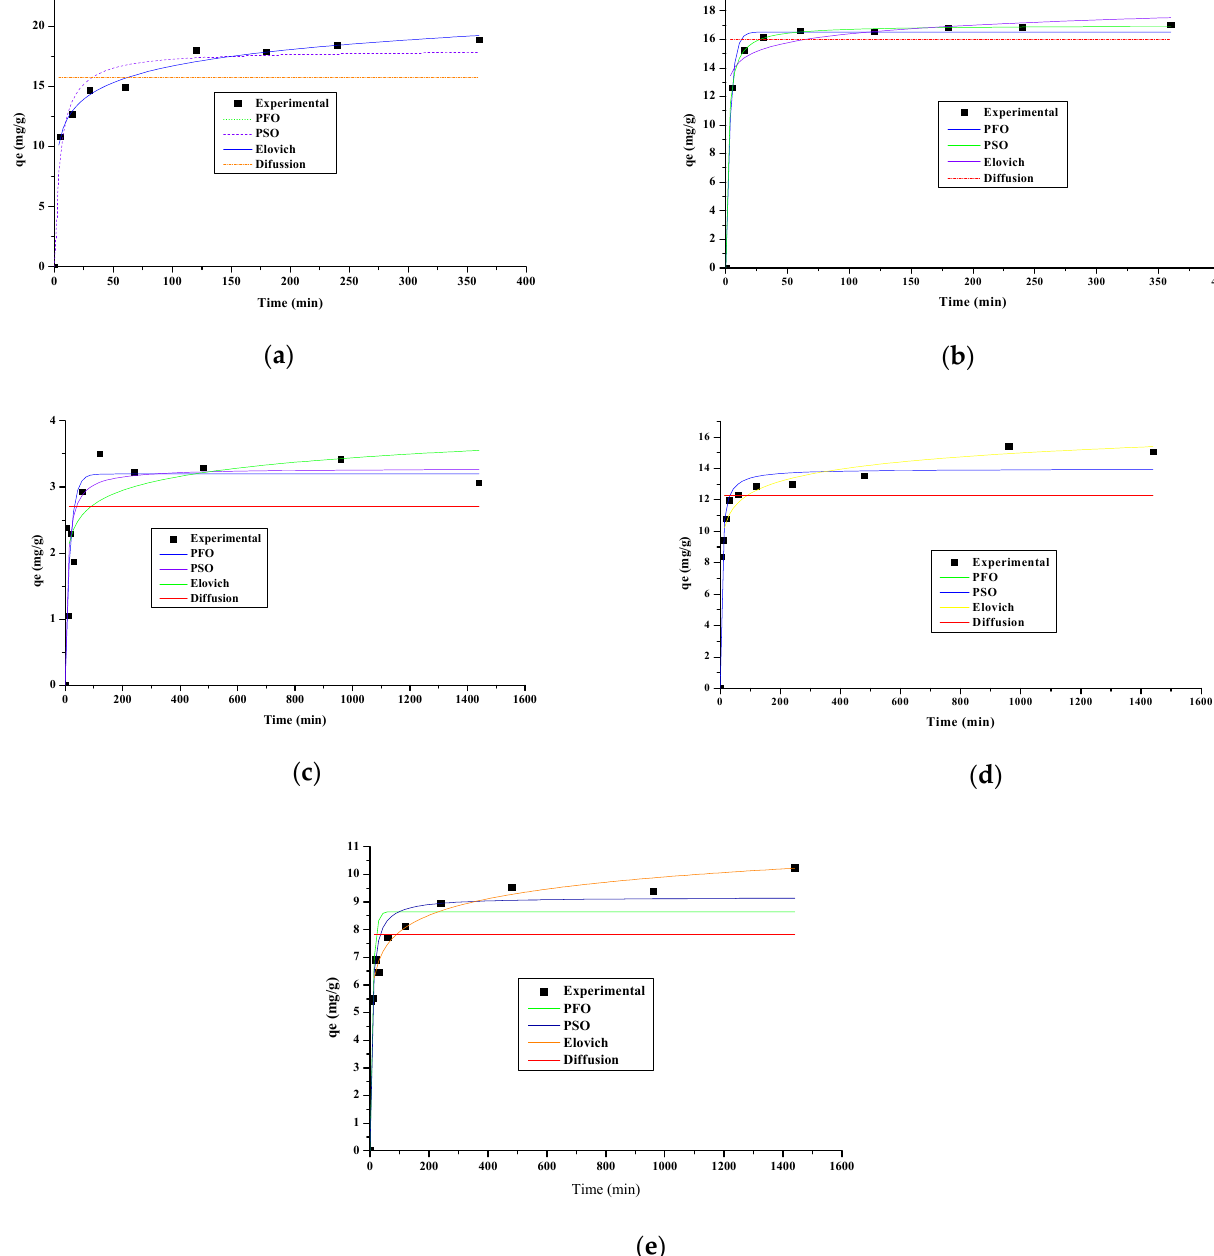
Figure 6. Fitting to Pseudo-first order, Pseudo-second order, Elovich and intraparticle diffusion adsorption kinetic models adjustment for removal of Cd 2+ ions on ( a ) YP, ( b ) OPB, ( c ) CH, ( d ) CP and ( e ) CCR. Table 4. Adjustment parameters of the Pseudo-first order, Pseudo-second order, Elovich and Intraparticle difussion’s models of Cd 2+ adsorption onto YP, OPB, CH, CP and CCR.